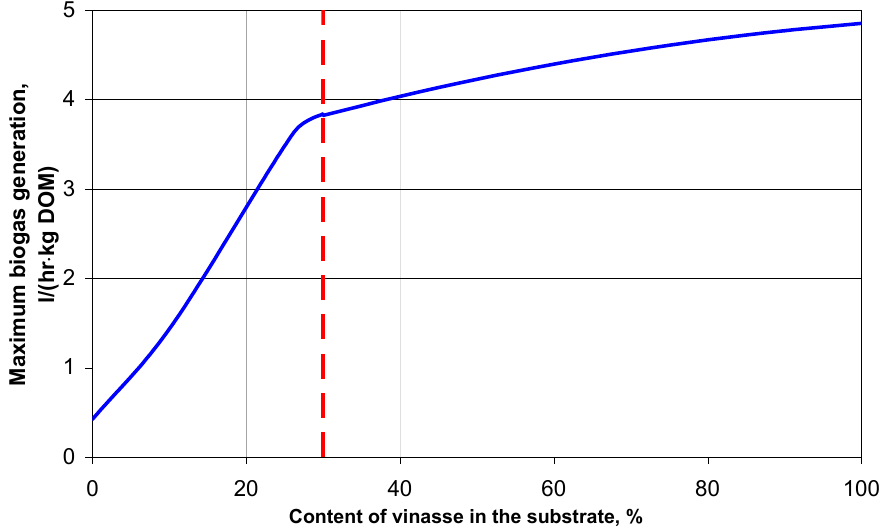
Figure 7. Modelled biogas output from cattle manure digestion from molasses vinasse for the quasi-continuous loading of a methane tank.